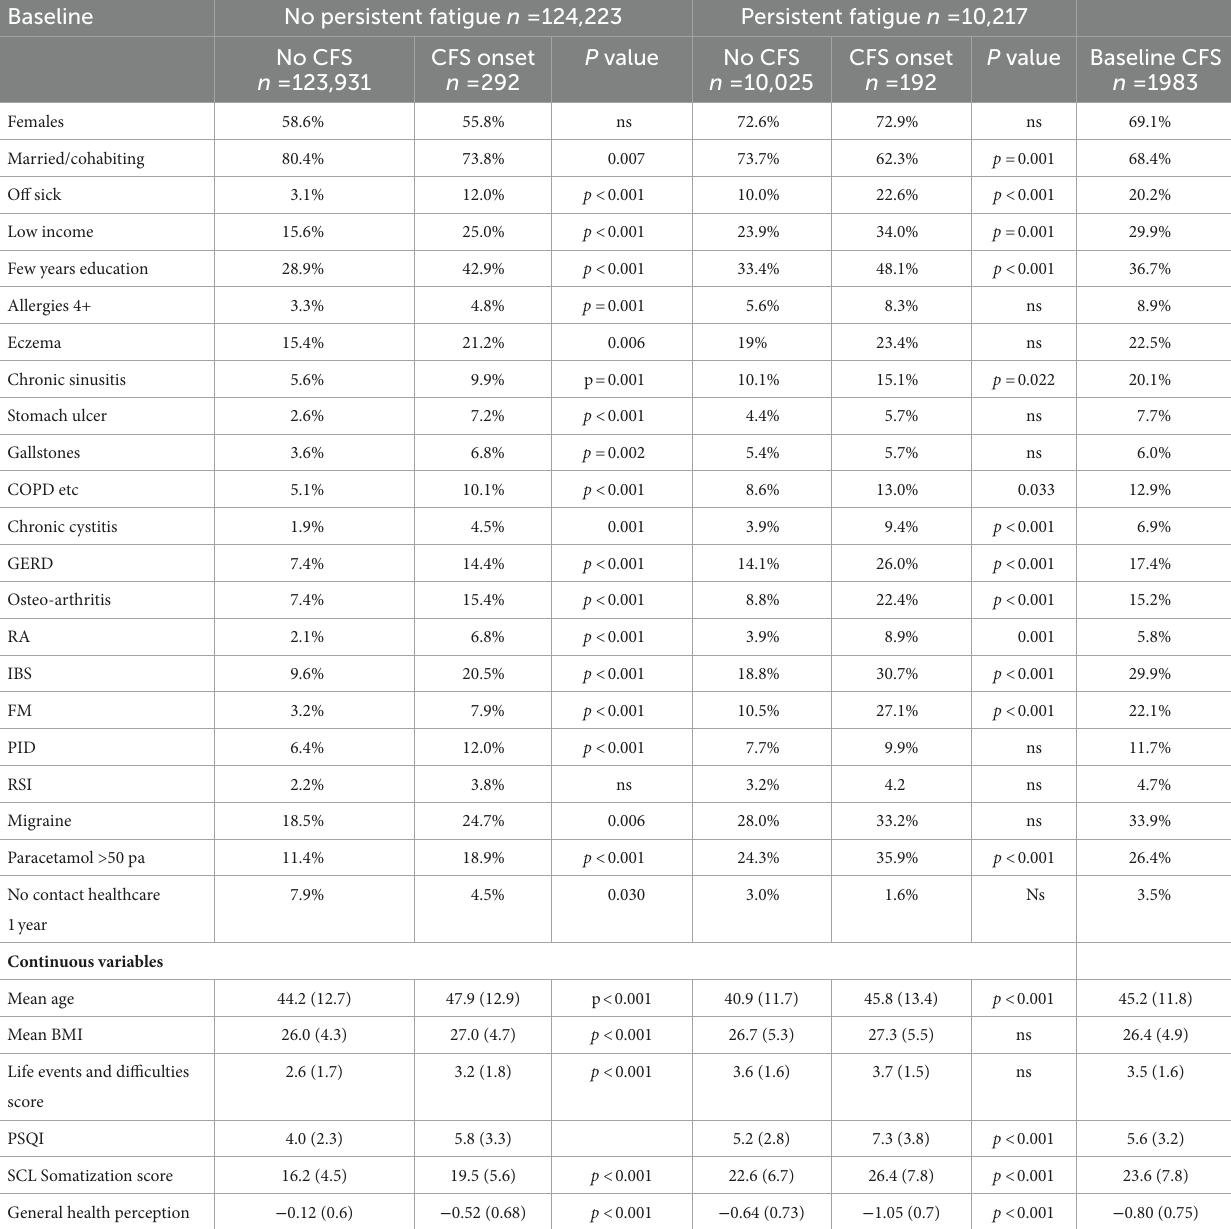
TABLE 2 Potential predictors of self-rated chronic fatigue syndrome onset by baseline fatigue severity.